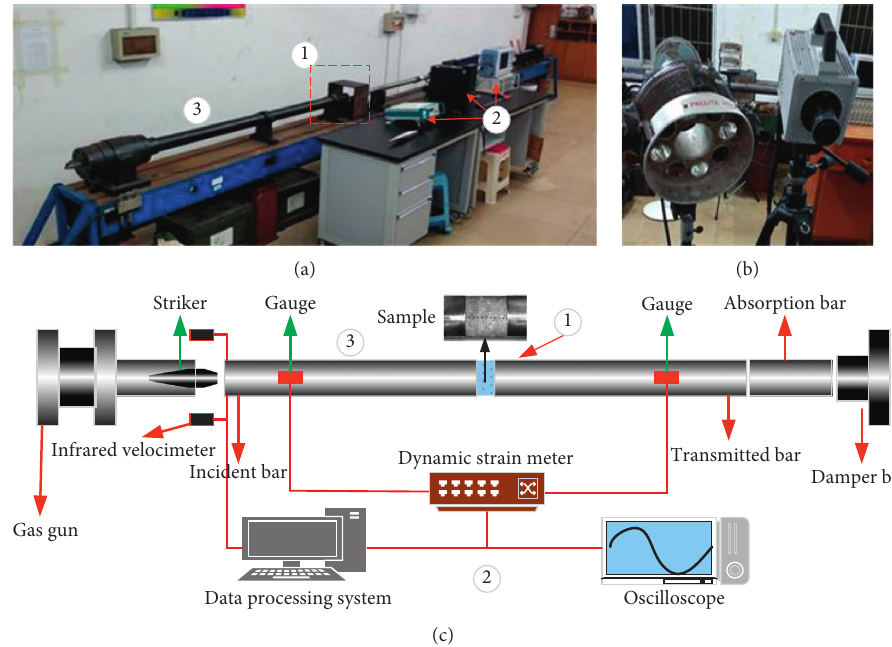
Figure 5: The split Hopkinson pressure bar test system. (a) SHPB device. (b) High-speed camera. (c) Schematic diagram.